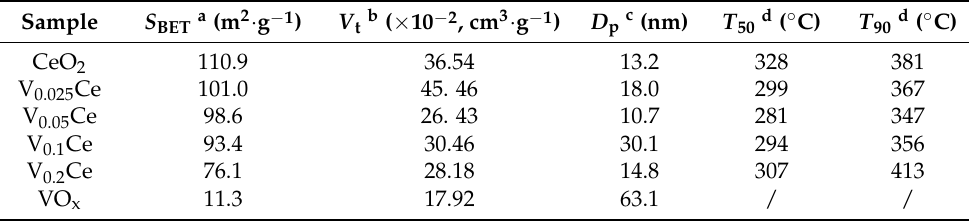
Figure 3. ( a ) Nitrogen adsorption/desorption isotherms and ( b ) pore size distribution of pre- pared catalysts. Table 1. Textural properties and catalytic performance of prepared